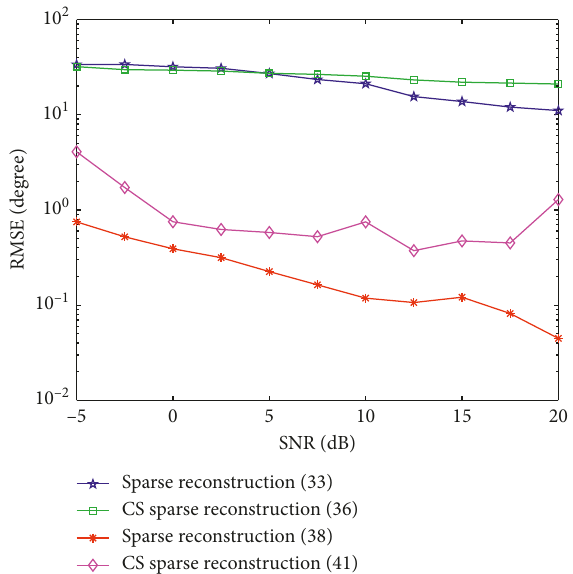
Figure 7: The RMSE of azimuth estimation vs. SNR for sparse reconstruction methods with and without CS involvements.